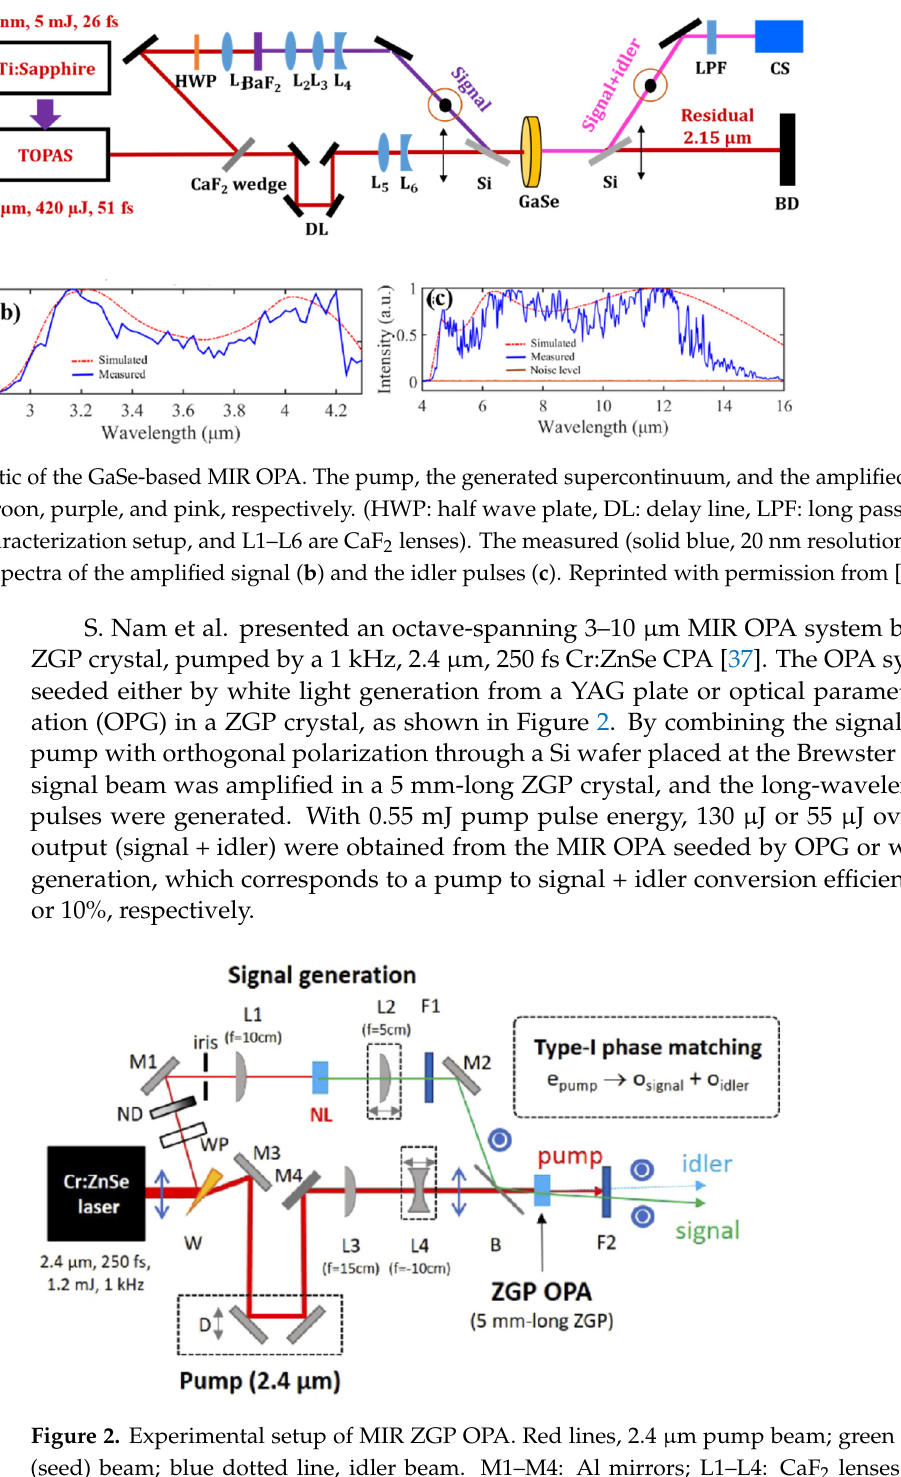
4 of 24 Figure 1. ( a ) The schematic of the high-energy phase-stable sub-cycle MIR OPA. Polarizations of the beams are marked by double-headed arrows and concentric circles. 300- μ m thick Si wafers at Brew- ster angle were used as polarization beam splitter and beam combiner to transmit the 2.1- μ m pump pulse and reflected the signal and idler pulses. The synthesized pulses and a branch of 2.1- μ m ref-